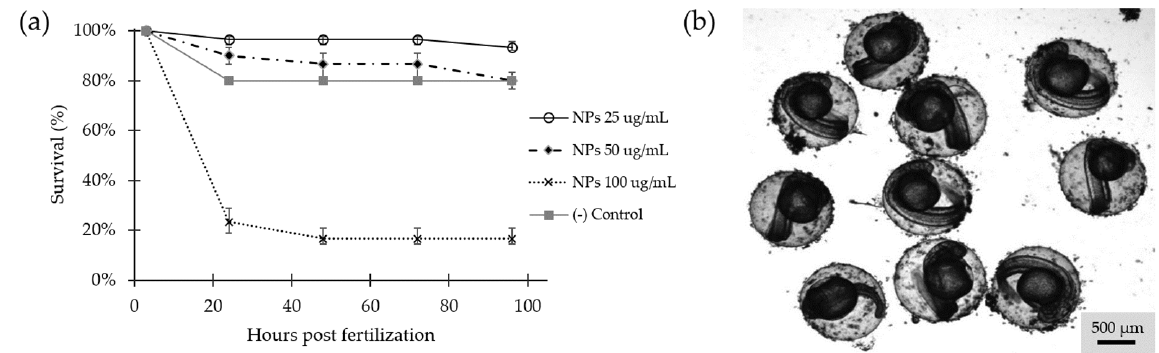
Figure 9. ( a ) Survival rate for embryos exposed to different concentrations of Fe 3 O 4 NPs @APTES (25, 50 and 100 µg/mL) compared with the control group. Data are showed as percentage of survival ( n = 30 embryos for each concentration and a control that was normalized to the highest survival well). ( b ) Stereoscope image of 48 hpf embryos exposed to Fe 3 O 4 NPs @APTES at 25 µg/mL.